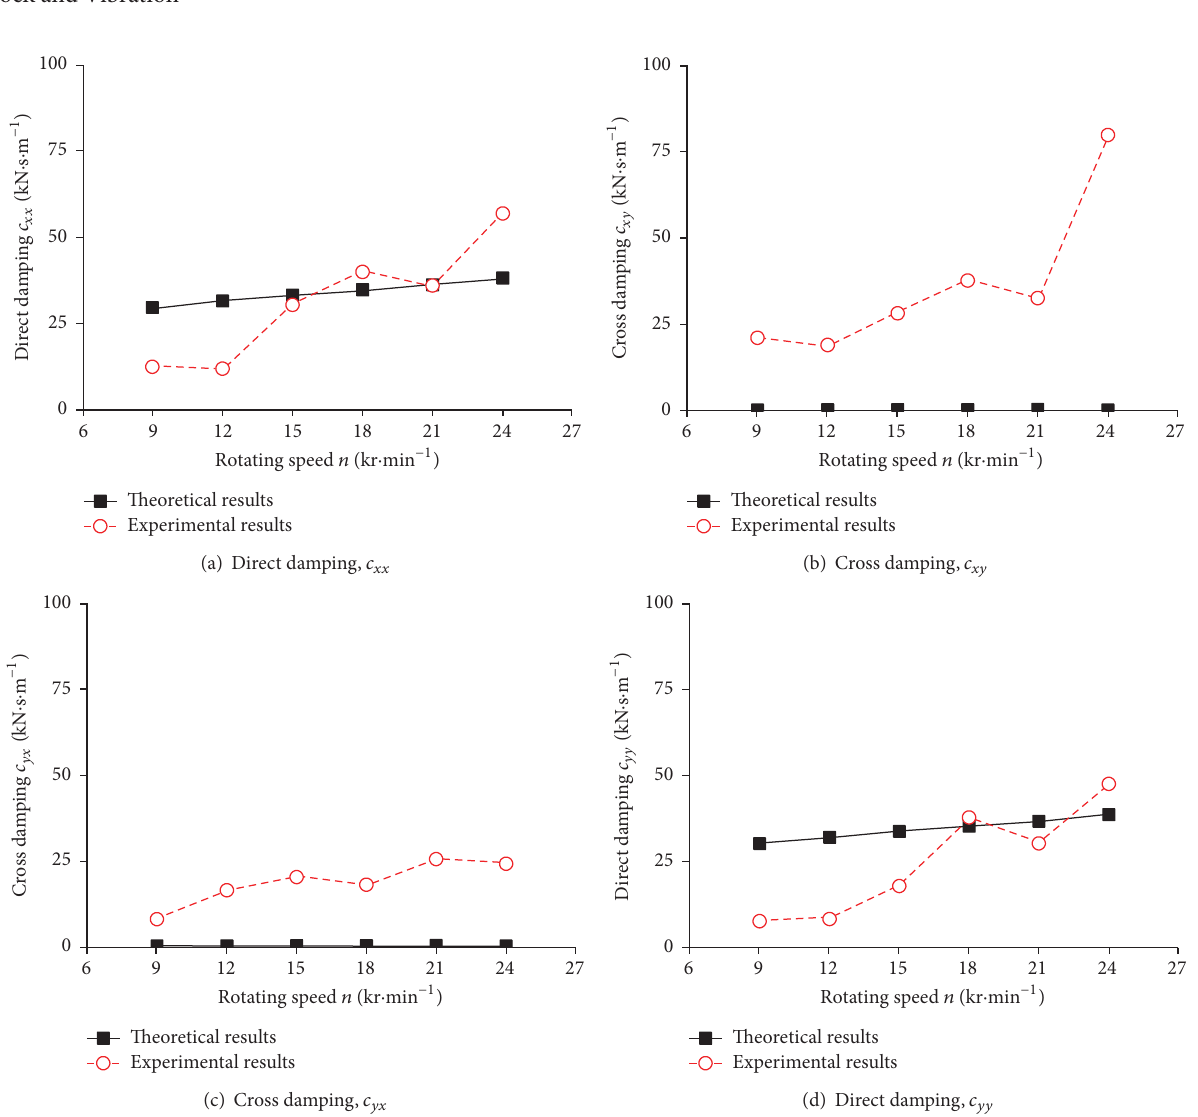
Figure 7: Comparative results of the damping coefficients by additional unbalance excitation: one water supply pressure (2.5 MPa) and six journal rotating speeds (9,000 r/min to 24,000